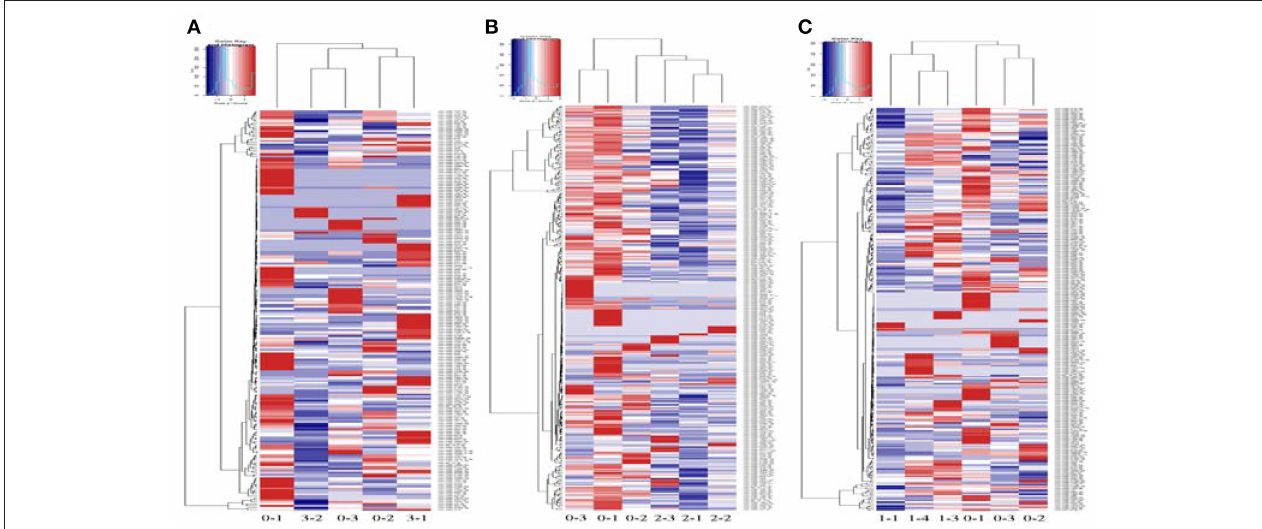
FIGURE 7 | Expression levels of plasma/CSF exosomal rno-miR-122-5p and rno-miR-300-3p in sham controls and the ischaemia groups ( n = 5 each group; * P < 0.05, # P < 0.01, & P < 0.001). (A,B) Relative expression of plasma exosomal rno-miR-122-5p and rno-miR-300-3p. (C,D) Relative expression of CSF exosomal rno-miR-122-5p and rno-miR-300-3p.